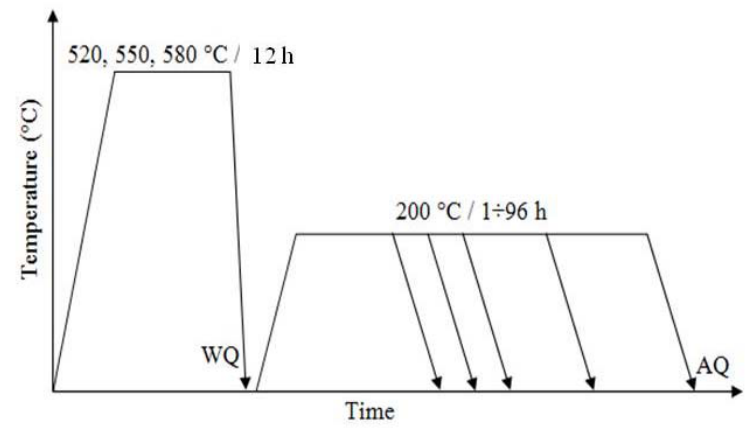
Figure 1. Schematic diagram indicating the heat treatment cycles used in the present investigation.